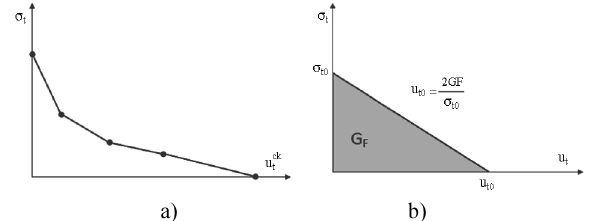
Fig. 4. Post failure stress-strain relation with fracture energy approaches (ABAQUS User Manuel 2009)